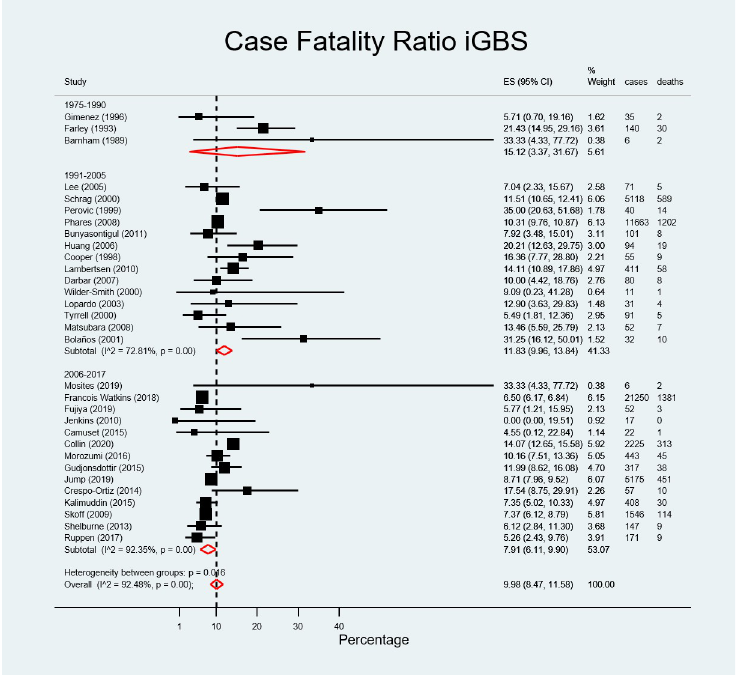
Fig 5. Pooled estimated case fatality ratio of invasive group B streptococcal infection by study period. Serotype distribution. A total of 29731 isolates from non-pregnant adults were serotyped of which serotype V was the most common accounting for 43.48% (n = 12926) of isolates, fol- lowed by serotype Ia, 18.31% (n = 5443) and serotype III, 11.72% (n = 3483). In relation to